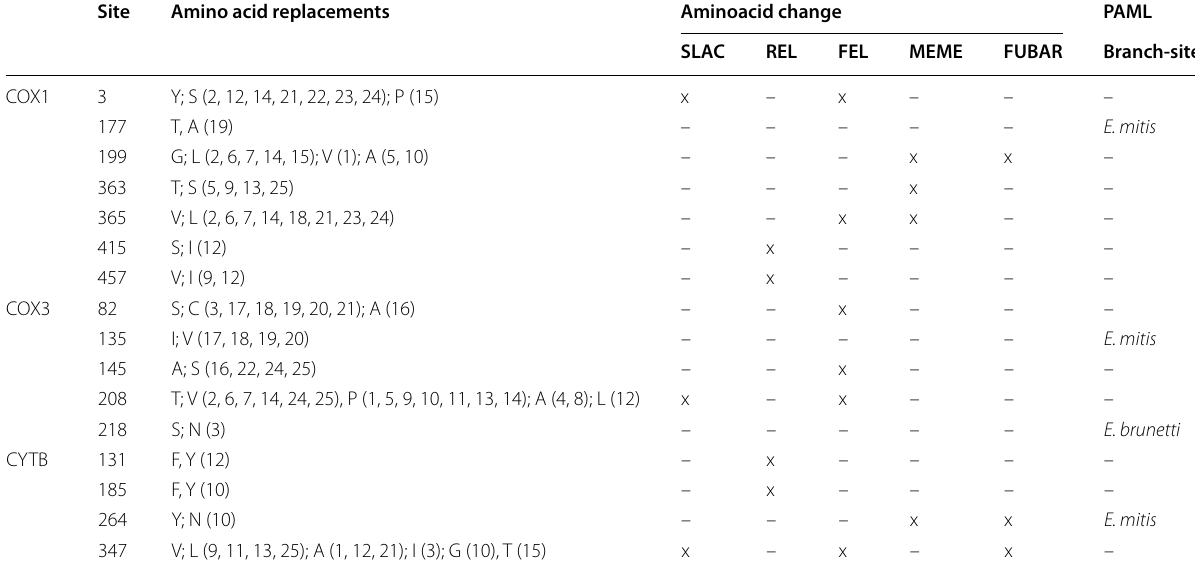
List of amino acid replacements fixed within mtDNA lineages of Eimeria species (for species names see Table